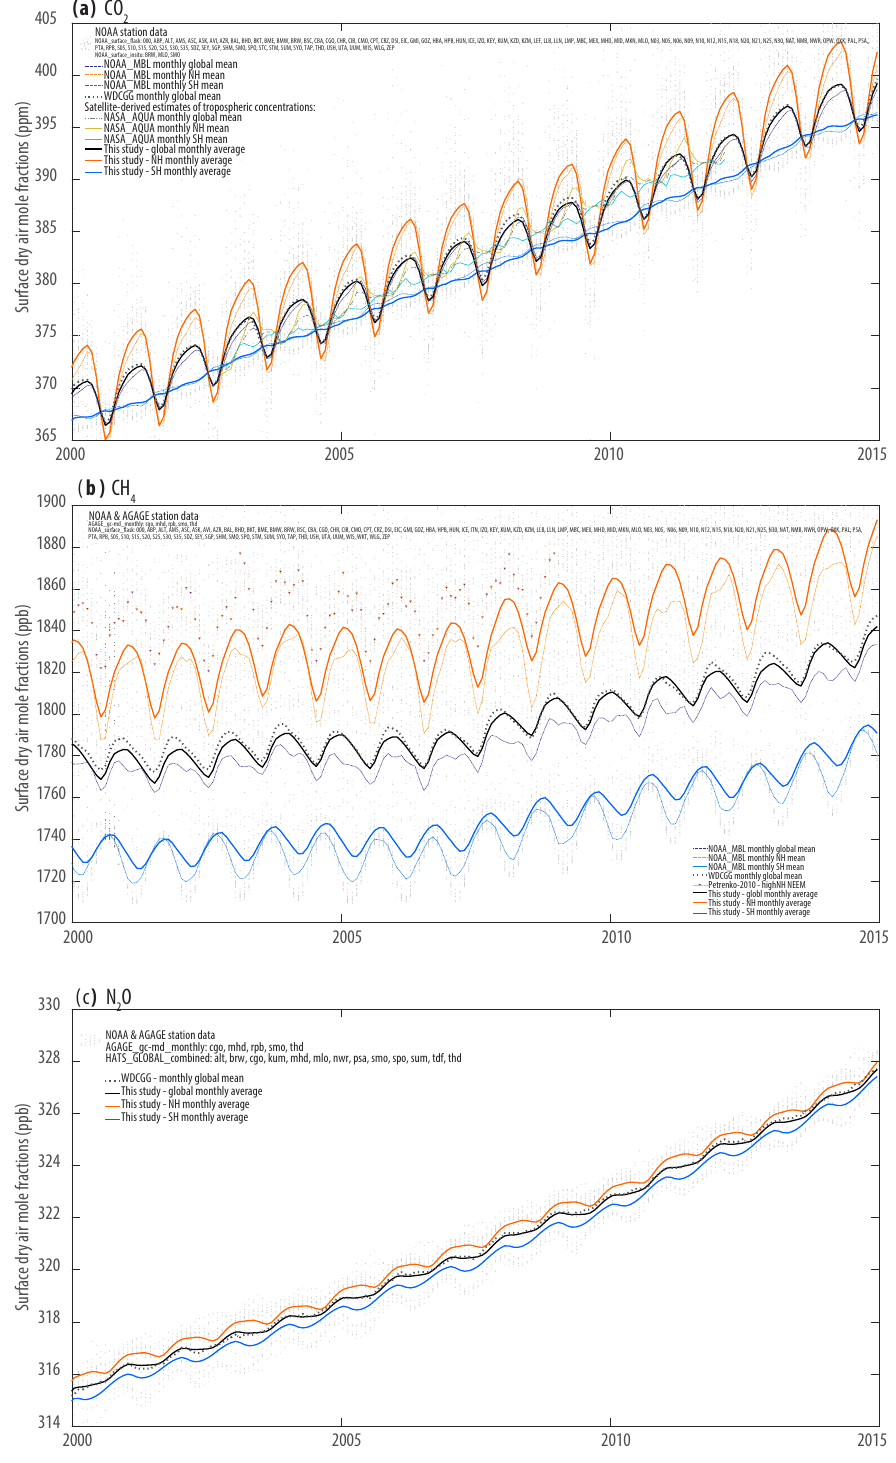
Figure 16. Comparison of global-mean and hemispheric monthly-average concentrations of CO 2 (a) , CH 4 (b) and N 2 O (c) between the CMIP6 surface mole fractions (this study), the NOAA Marine Layer Boundary products, the World Data Centre of Greenhouse gases (WDCGG) products and the NASA AQUA satellite data of tropospheric CO 2 concentrations. For comparison, individual (monthly average) NOAA and AGAGE station data across all latitudes is shown in the background (grey